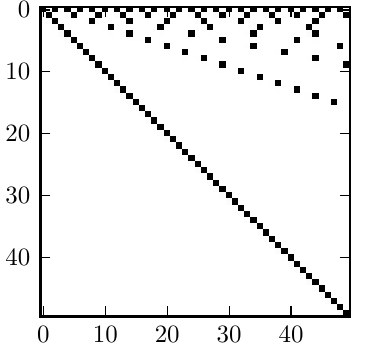
; non-zero entries are black. I,Q